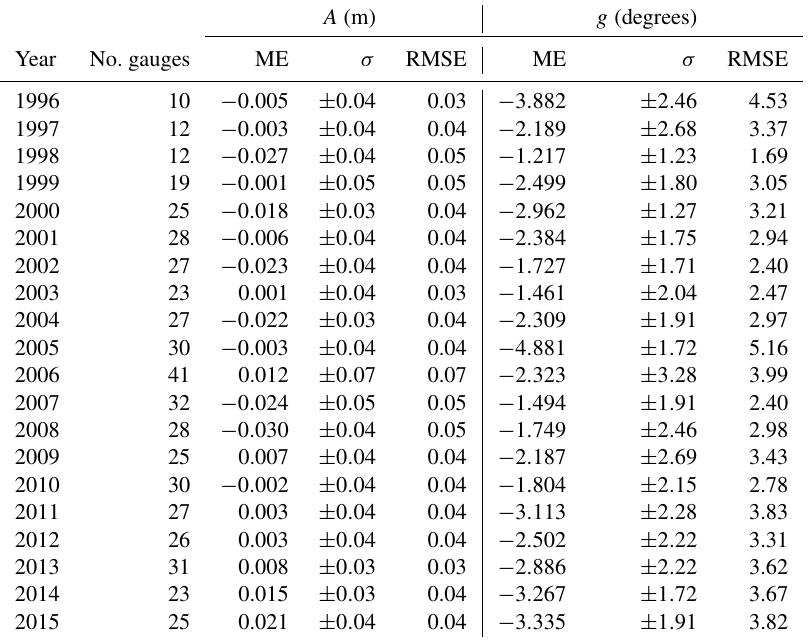
Table 1. Mean error (ME), standard deviation ( σ ), and root mean square error (RMSE) of amplitude A in meters and phase g in degrees of the M 2 tidal constituent for years 1996 to 2015. The number of gauges (No. gauges) available varies in individual years because of limited data availability and quality.